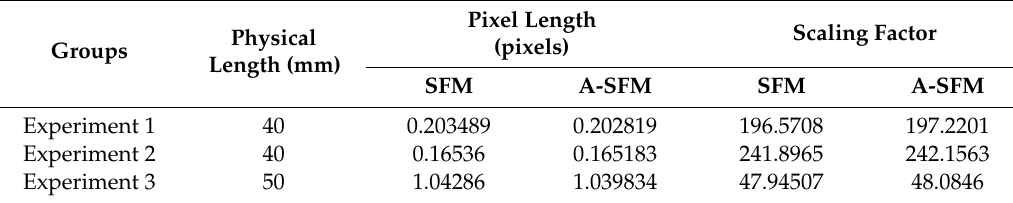
Table 7. The scaling factor for each group. Sfm, structure from